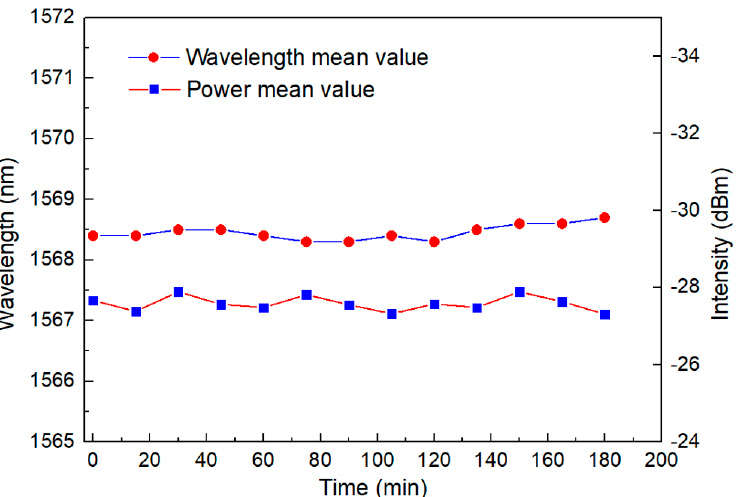
Figure 14. Amplitude diagram of the wavelength and intensity shift within 3 h at 20 °C.